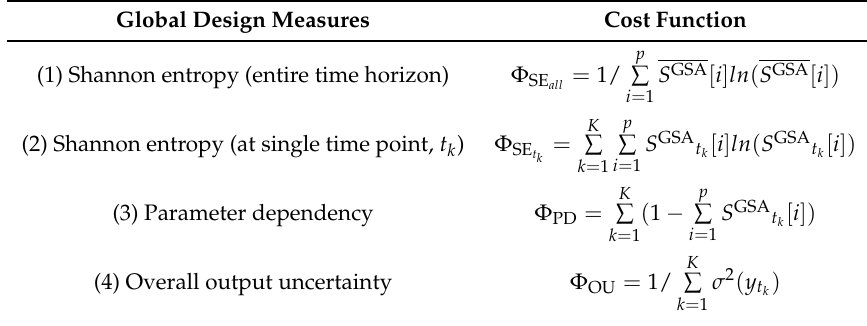
Table 5. Global design measures for MB-OED based on Sobol indices and Shannon entropy.